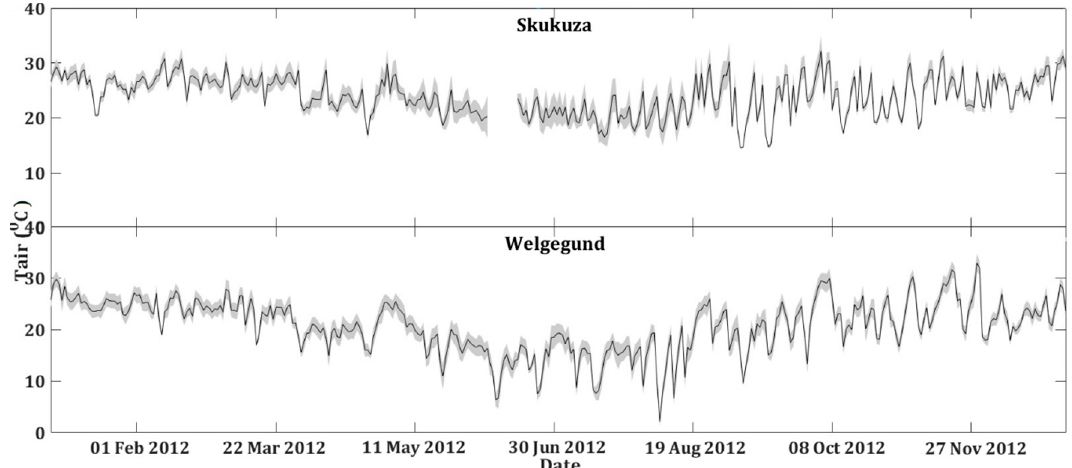
Figure 2. Daily average air temperature of year 2012 for the two study sites. The grey bounds indicate the absolute uncertainties, which were added as standard deviations.